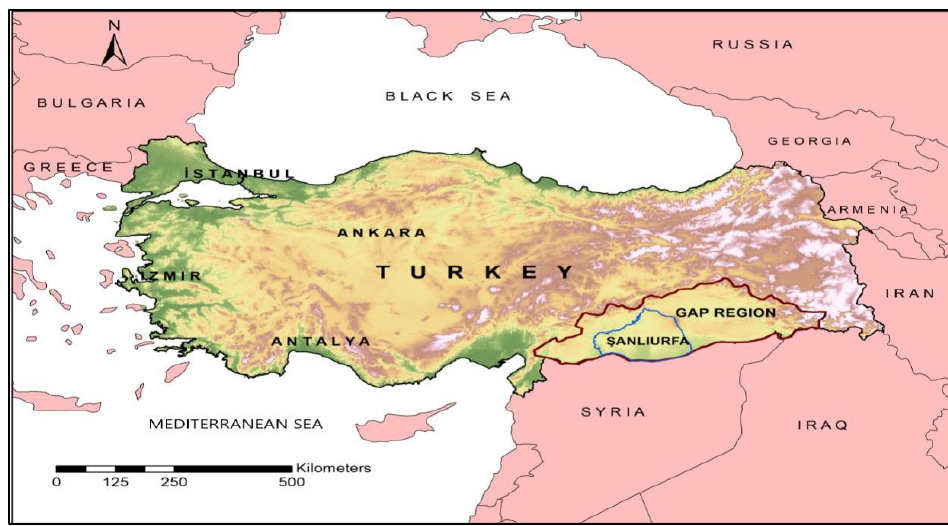
Figure 1. The locations of the GAP region and province of Şanlıurfa in Turkey .